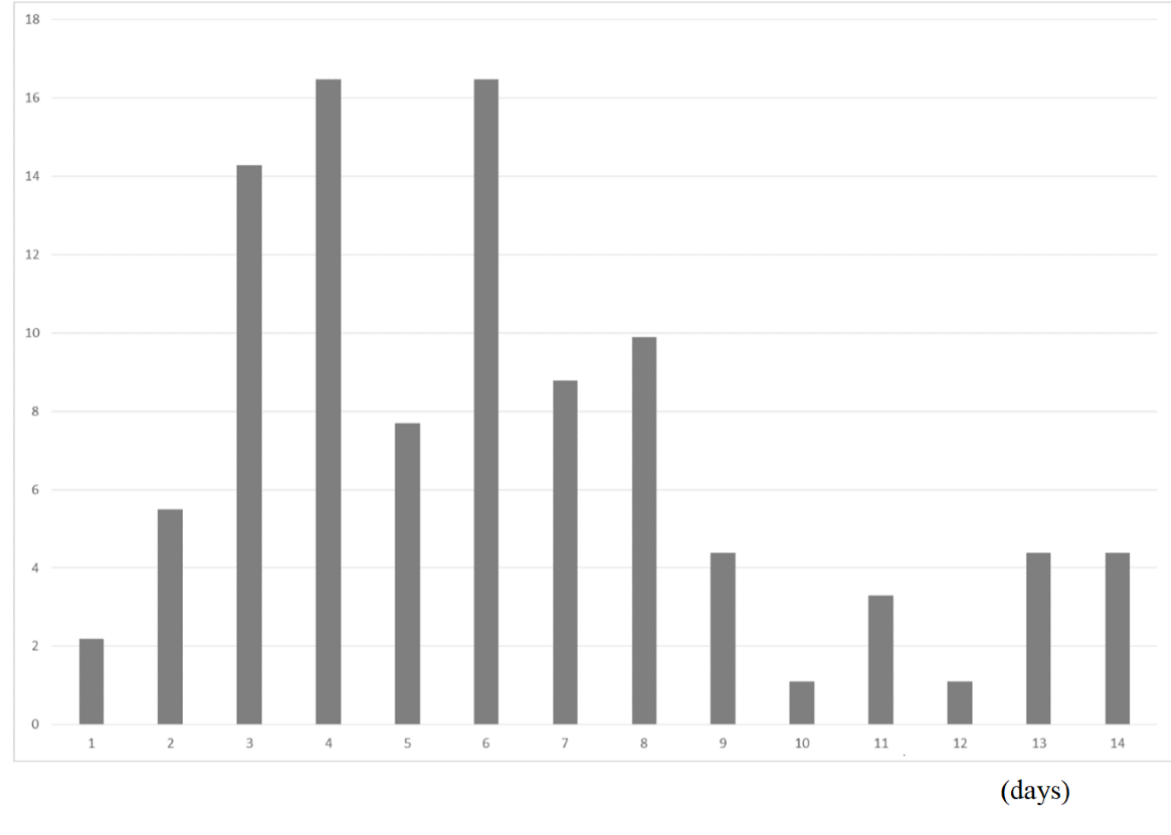
Figure 3. Empirical distribution of the incubation period published by Ministry of Labour, Health and Welfare (MLHW) in Japan. Bars show the distribution of incubation periods for 91 cases for which MLHW Japan had published the exposure date and the onset date. The patients for whom incubation was longer than 14 days are included in the bar shown for day 14.